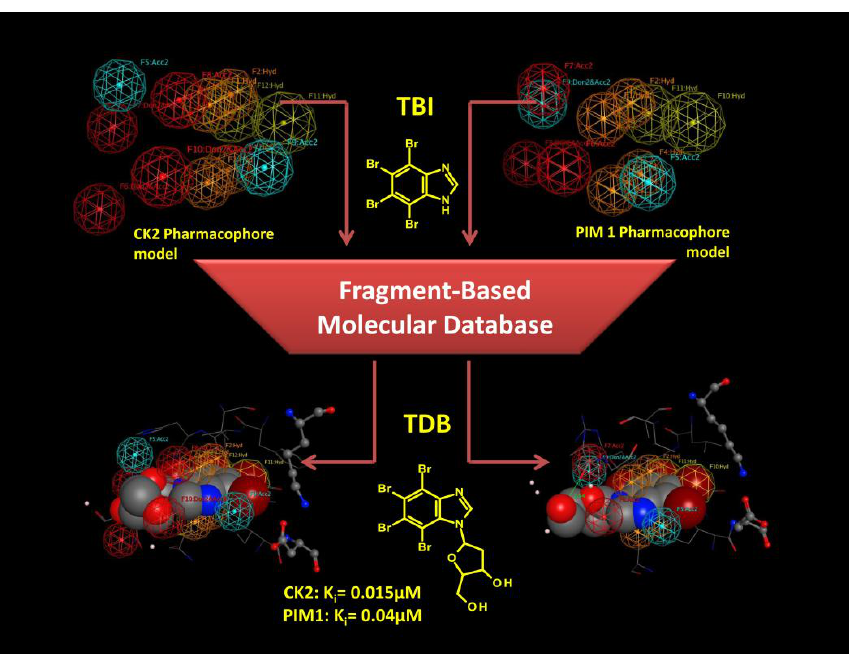
Figure 7. Structure based pharmacophore screening applied for the discovery of TDB (1-β-D-2′-deoxyribofuranosyl-4,5,6,7-tetrabromo-1H-benzimidazole), a CK2 and PIM1 dual inhibitor. Spheres represent chemical features: Red for donor, blue for acceptor, orange and yellow for hydrophobic/aromatic. Table 2. List of CK2 and PIM1 crystal structures (PDB codes) used as training and test set for pharmacophore building.